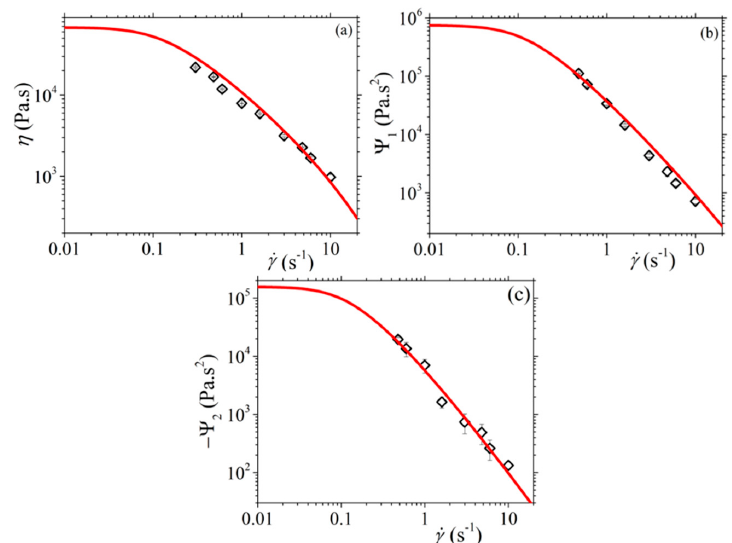
Figure 6. Comparison of the model predictions with the experimental data considered in Ref. [17] for: ( a ) the shear viscosity, ( b ) the first normal stress coefficient, and ( c ) the second normal stress coefficient, at steady state. Model parameters: α = 0.4, b e = 54, β ccr = 0.06, and ξ = 0.03 (the rest are the same as in Figure 5).